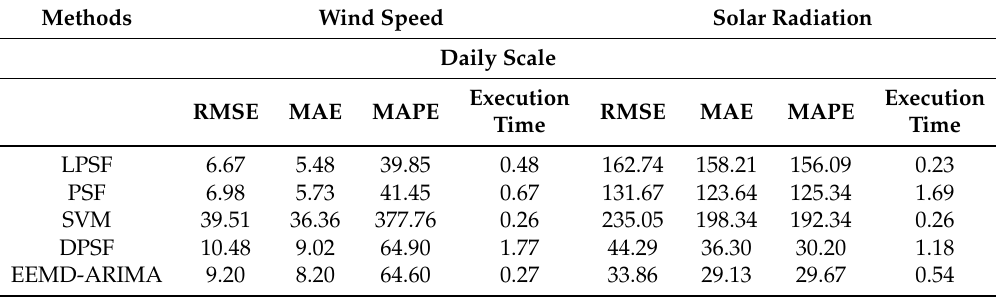
Table 2. The statistical performance of the forecasting wind speed and solar radiation at Watford City station for the daily, weekly and monthly time scale for the applied (LSPF and PSF) and the comparable predictive models (i.e., SVM, DPSF and